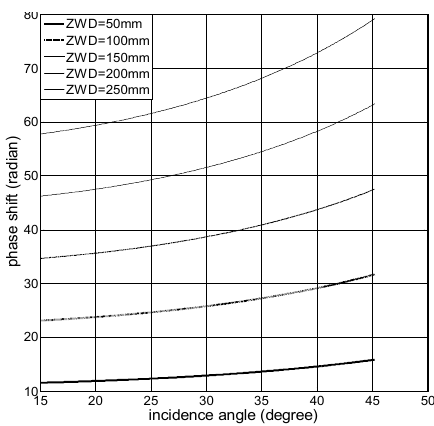
Figure1. Phase change tendencywith increasing incident